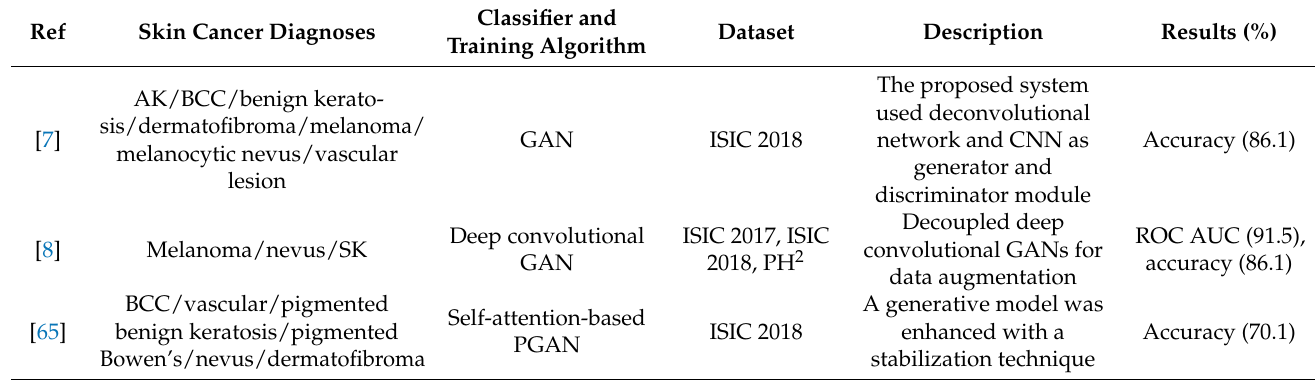
Table 8. A comparative analysis of skin cancer detection using GAN-based approaches.